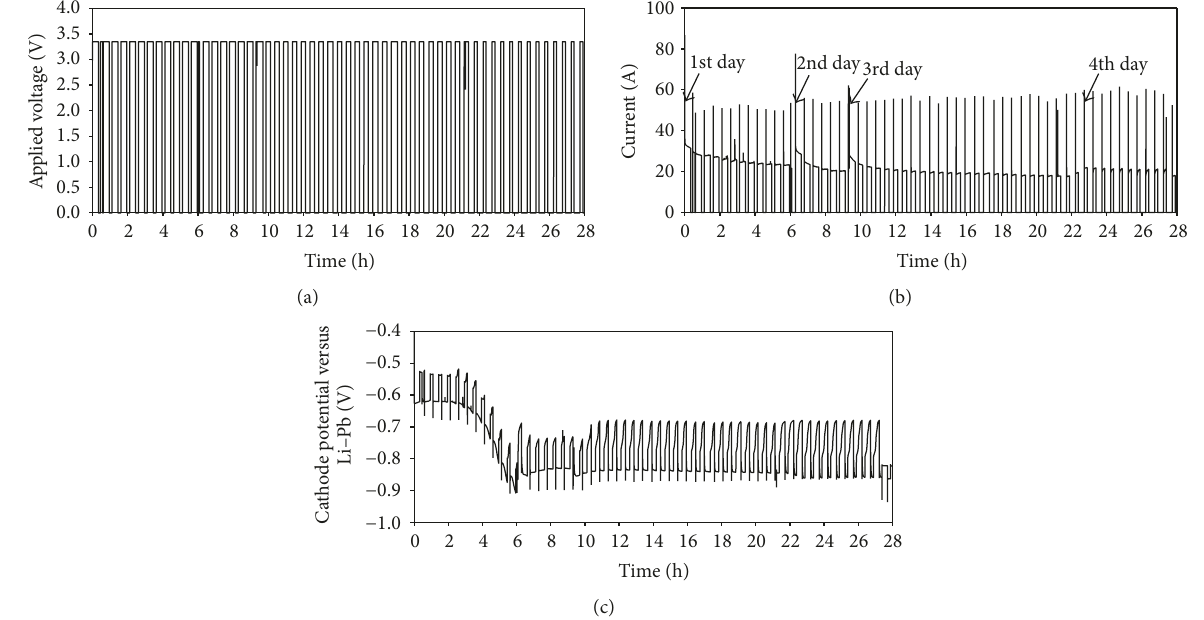
Figure 5: Diagrams from the first OR run: (a) the applied voltage versus time, (b) the response current versus time, and (c) the cathode potential versus